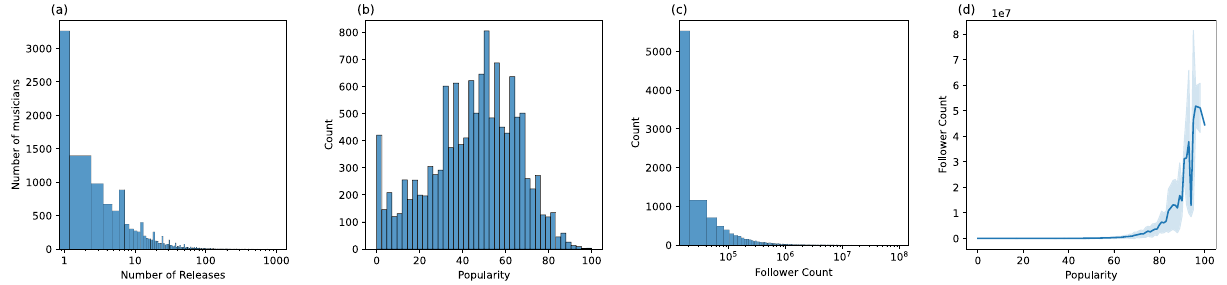
Figure 1. ( a ) Release Count distribution of musicians. ( b ) Popularity score distribution of musicians. ( c ) Follower Count distribution of musicians. ( d ) Follower count associated with